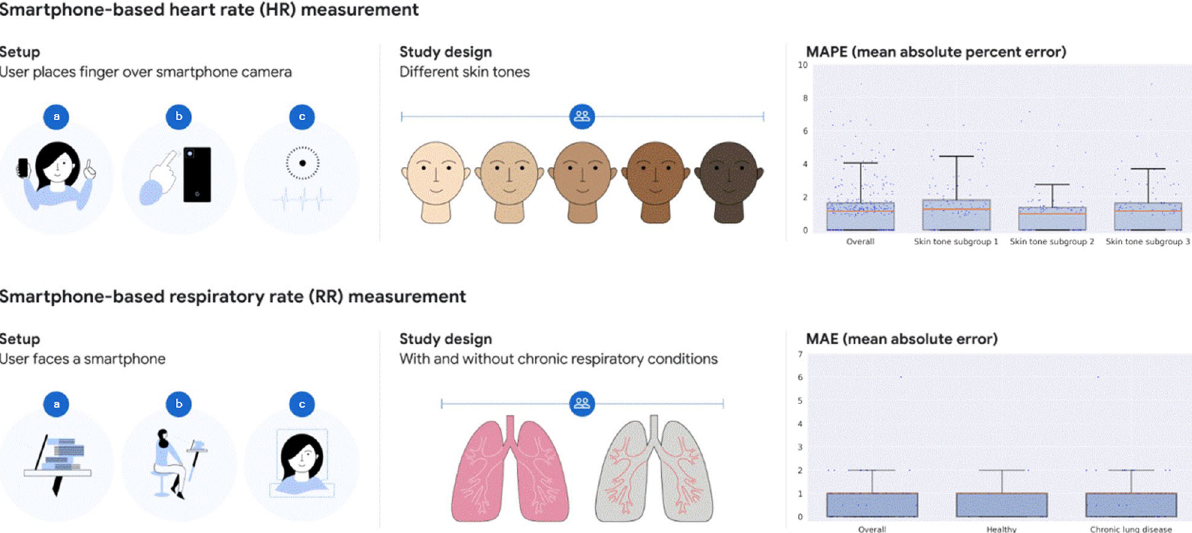
Fig. 1 Smartphone-based monitoring of two key vital signs: heart rate (HR) and respiratory rate (RR). Setup of how measurements are taken: with the fi nger over the rear-facing camera for HR (upper panel) and using a video of the participant via the front-facing camera for RR (lower panel). Study design: to ensure generalization across skin tones for HR ( n = 95) and generalization to participants with chronic respiratory conditions (chronic obstructive pulmonary disease and asthma) for RR ( n = 50). Skin-tone subgroup 1 ( n = 31) corresponds to Fitzpatrick skin types 1 – 3 (very light, light, and intermediate); subgroup 2 ( n = 32) corresponds to types 4 – 5 (tan and brown); and subgroup 3 ( n = 32) corresponds to type 6 (dark). RR study included healthy participants ( n = 10) and participants with chronic respiratory conditions ( n = 40). Metrics: the main measurements were mean absolute percent error (MAPE) for HR and mean absolute error (MAE) for RR. In the boxplots, the orange lines and box edges indicate the quartiles; whiskers indicate 1.5 times the interquartile range beyond the upper and lower quartiles; dots indicate individual data points (average percent error or absolute error). For the HR study, fi ve outlier data points in the “ overall ” group extend beyond the axes (>10%) and are not shown; these outliers are distributed across the three skin tone subgroups (1, 2, and 2, respectively). All data points are shown for the RR